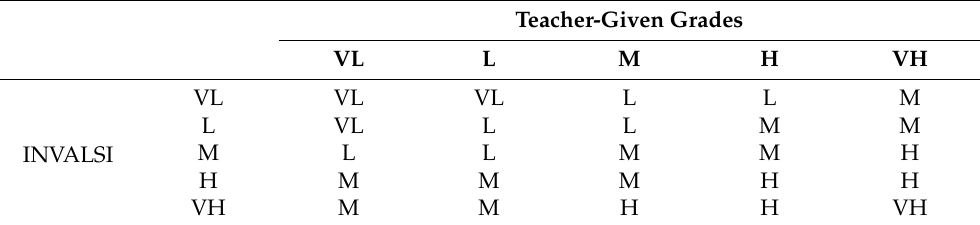
Table 5. Inference rules.